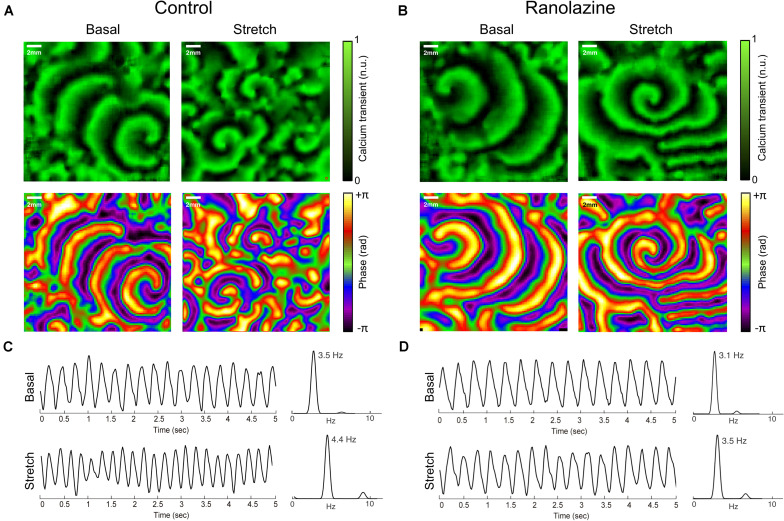
Overview of the effects of ranolazine on stretch-induced changes in atrial activation patterns. CaT (top) and phase (bottom) maps of representative cell cultures in basal situation (left) and during stretch (right), under control conditions (A), and ranolazine action (B). Time series of CaT optical signals and the corresponding power spectrum of the analyzed region in basal situation (top) and during stretch (bottom) for (C) control and (D) ranolazine conditions.